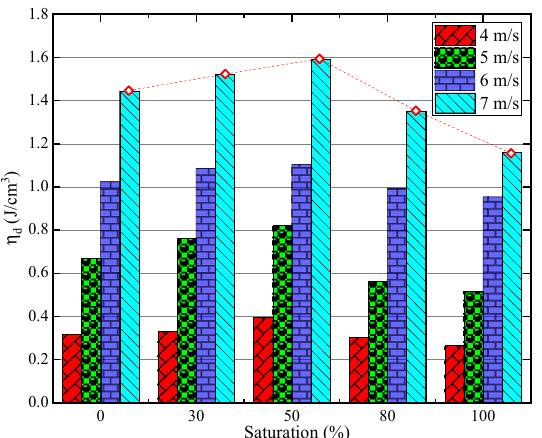
Figure 16. Dissipated energy per unit volume ( η d ) of samples at low temperatures.